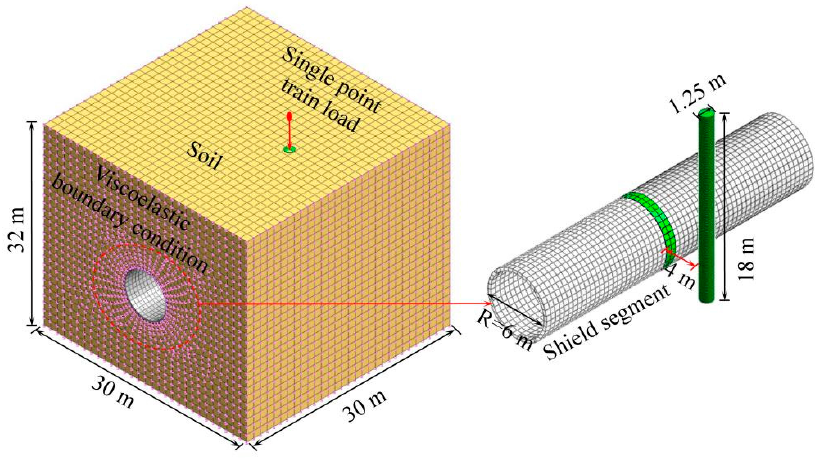
Figure 5. Numerical calculation model.